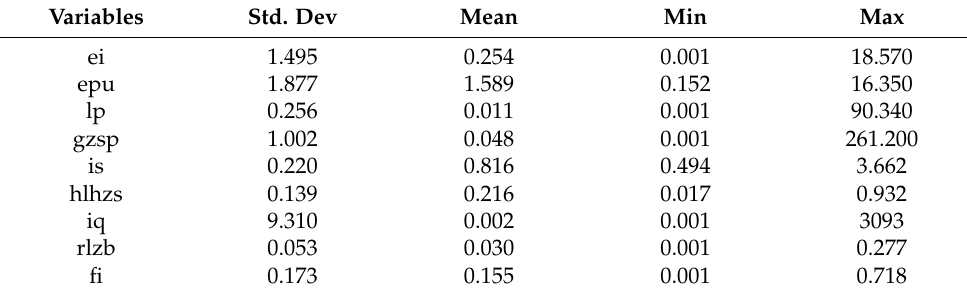
Table 1. Descriptive statistics of variables.